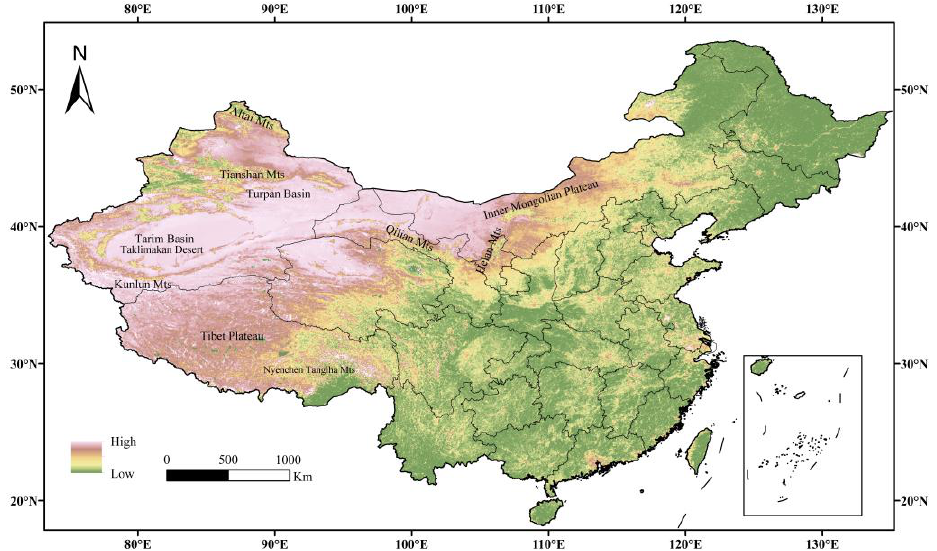
Figure 1. The map of drought levels in China is shown through a map of normalized difference vegetation index (NDVI).